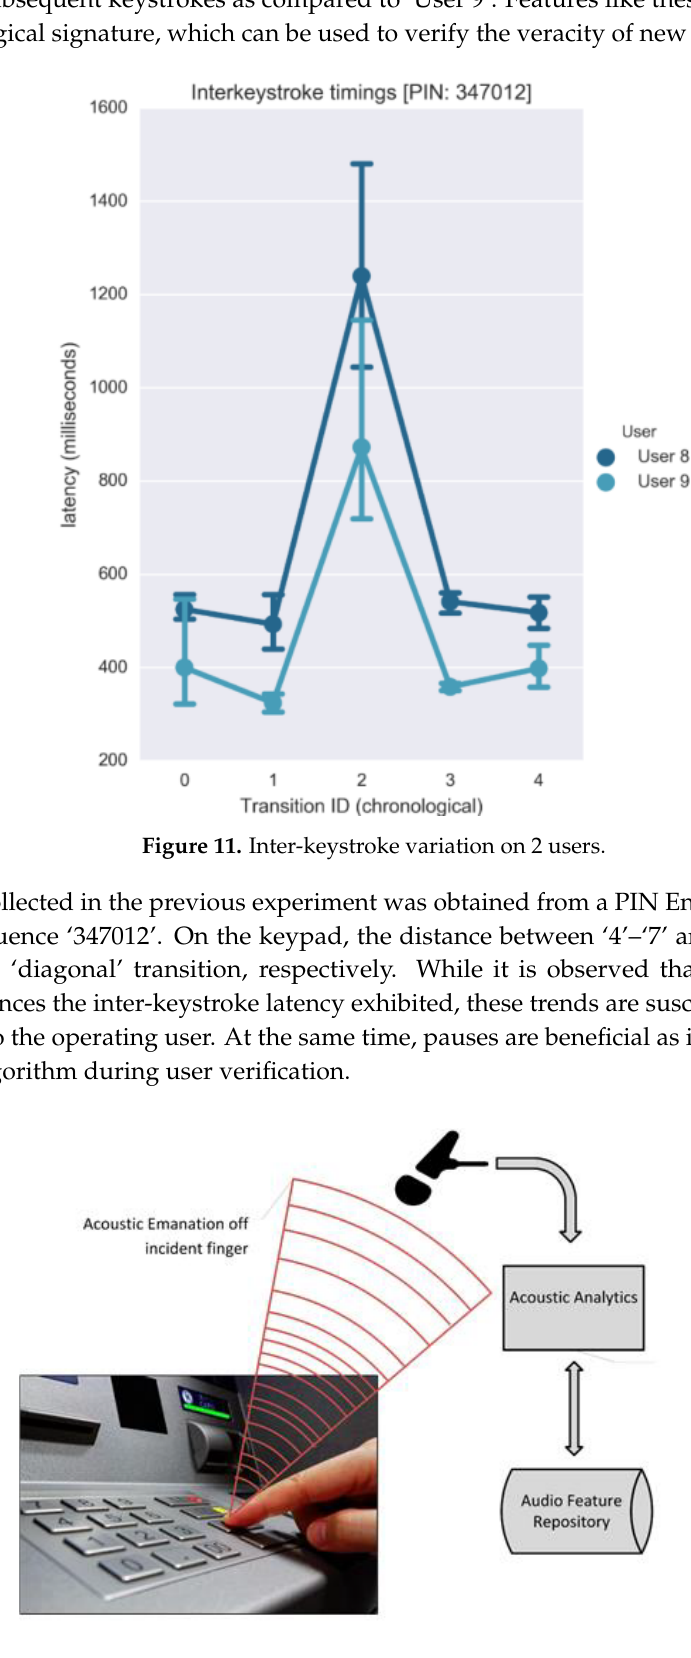
Figure 12. Data collection ATM